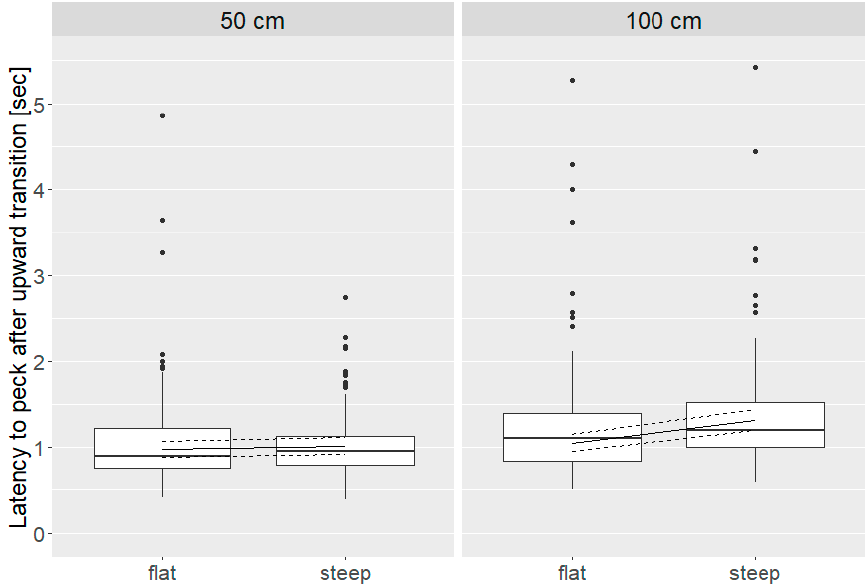
Figure 7. Latency to peck (sec) after upward transitions of 50 cm and 100 cm distance and flat and steep angle transitions (distance * angle: p = 0.001). Boxes show medians, lower and upper interquartile range. Whiskers indicate 1.5 times the interquartile range. In addition, model estimates with estimated means (solid line) and 95 % confidence intervals (dashed lines) are shown.